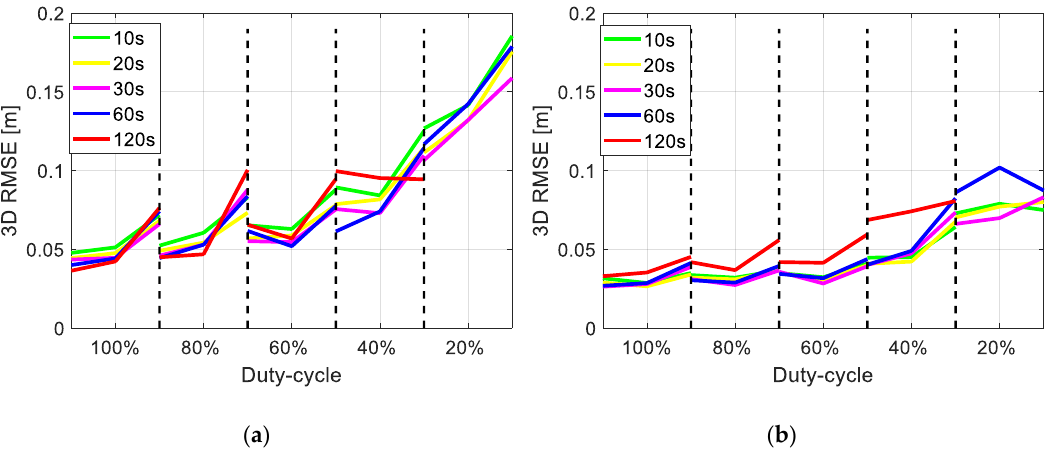
Figure 9. 3D RMSE of the reduced-dynamic orbits under different duty-cycles, observation sampling intervals and mean satellite numbers using ( a ) the IGR and ( b ) the IGC products. The cases having 9, 7, and 6 satellites (on average) are given between each pair of the dashed lines.